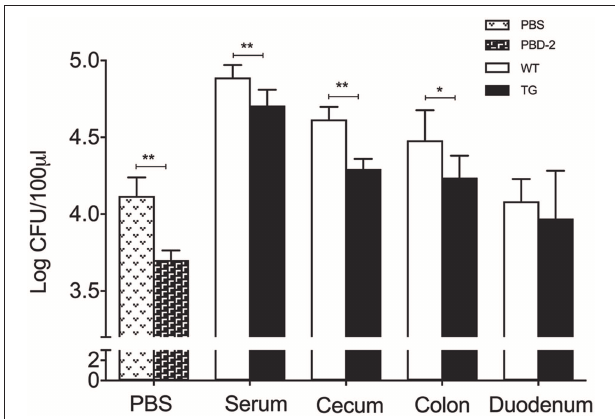
FIGURE 3 | Bactericidal activity of PBD-2 against S. Typhimurium. Synthetic PBD-2 after heat treatment and bacteria of 5000 CFUs were incubated in 10mM phosphate with 1/100 TSB for 1h. Bacteria were also incubated for 1h with heat-inactivated serum, homogenates of caecum, colon and duodenum of TG and WT mice. The bactericidal activity of PBD-2 is shown as the survived bacterial numbers after incubation with PBD-2 under the same heat-treatment or serum/tissue homogenates compared with the negative control. Data are represented as means ± SD (WT, n = 6; TG, n = 6). * p < 0.05, ** p <